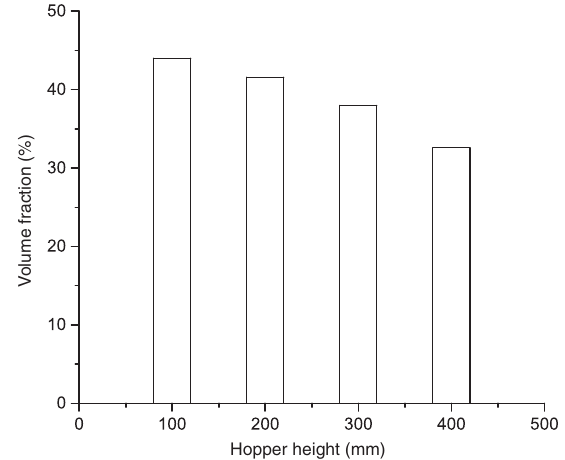
Figure 4: Influence of hopper height H on the volume fraction of WC particles in the